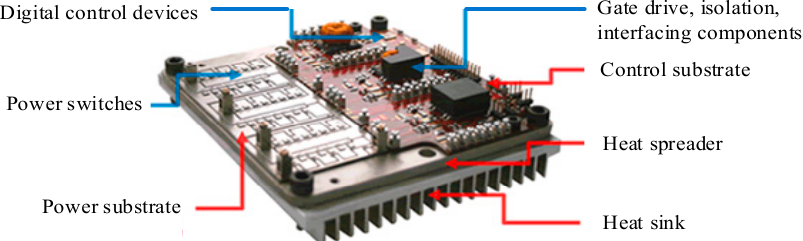
Figure 9. Multichip power module with high-density power electronics designed by Arkansas Power